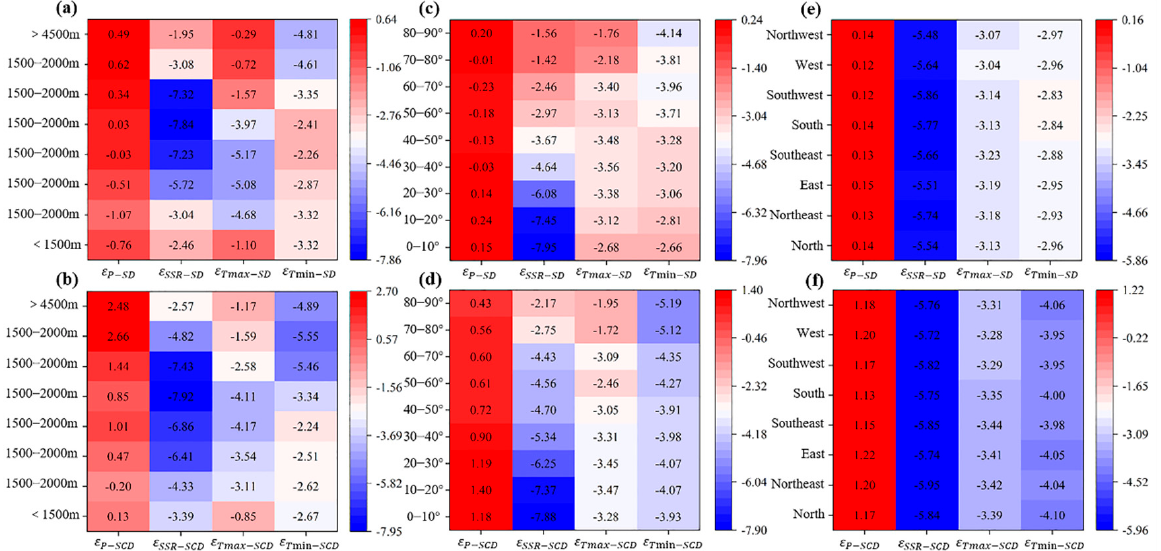
Figure 14. LSSP sensitivity statistics based on combinations of climatic and terrain factors. Subplots ( a , b ) are altitude-based, ( c , d ) are slope-based, and ( e , f ) are aspect-based. ( a , b ) are altitude-based, ( c , d ) are slope-based, and ( e , f ) are